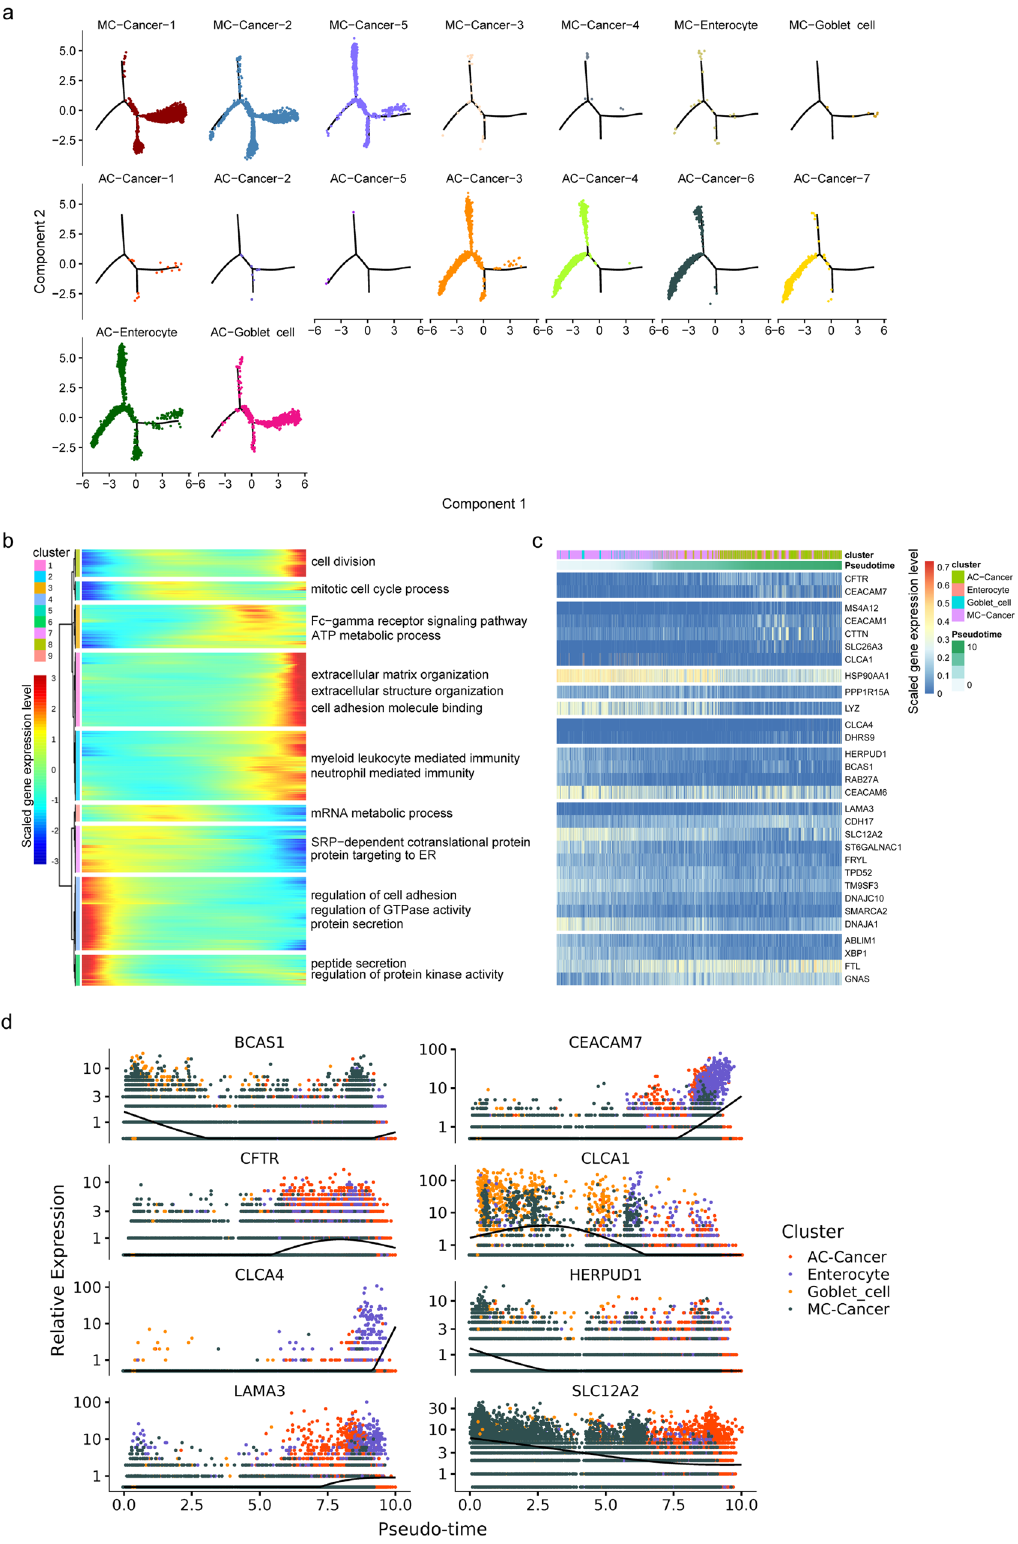
Fig. 7 Trajectory analysis of epithelial cells in MC and AC samples. a Distribution diagram of each cell type in the pseudotime trajectory. b The DEGs were hierarchically clustered into nine subclusters along the pseudotime trajectory. The top annotated GO terms in each cluster are provided. c Heatmap of the gene expression of the top 30 DEGs (in rows) along the pseudotime trajectory of the epithelial cells. The genes were grouped into nine clusters based on their expression patterns. d Expression of the top eight DEGs over pseudotime. The different colours indicate different cell types. All colour keys from blue to red represent the scaled gene expression levels from low to